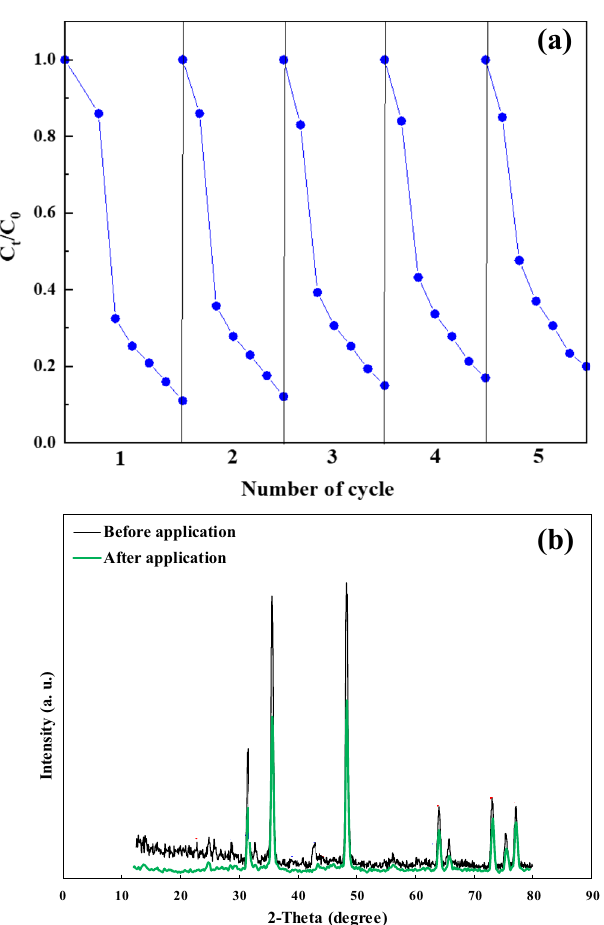
Fig. 6 The reusability and stability of the BaTiO 3 /WS 2 composite. a The piezo-photocatalytic degradation ef fi ciency of OFL and b XRD patterns of the BaTiO 3 /WS 2 composite before and after fi ve successive cycles. Experimental conditions: Catalyst concentration = 1.0 gL − 1 , [OFL] = 20mgL − 1 , [PS] = 10mM, pH =